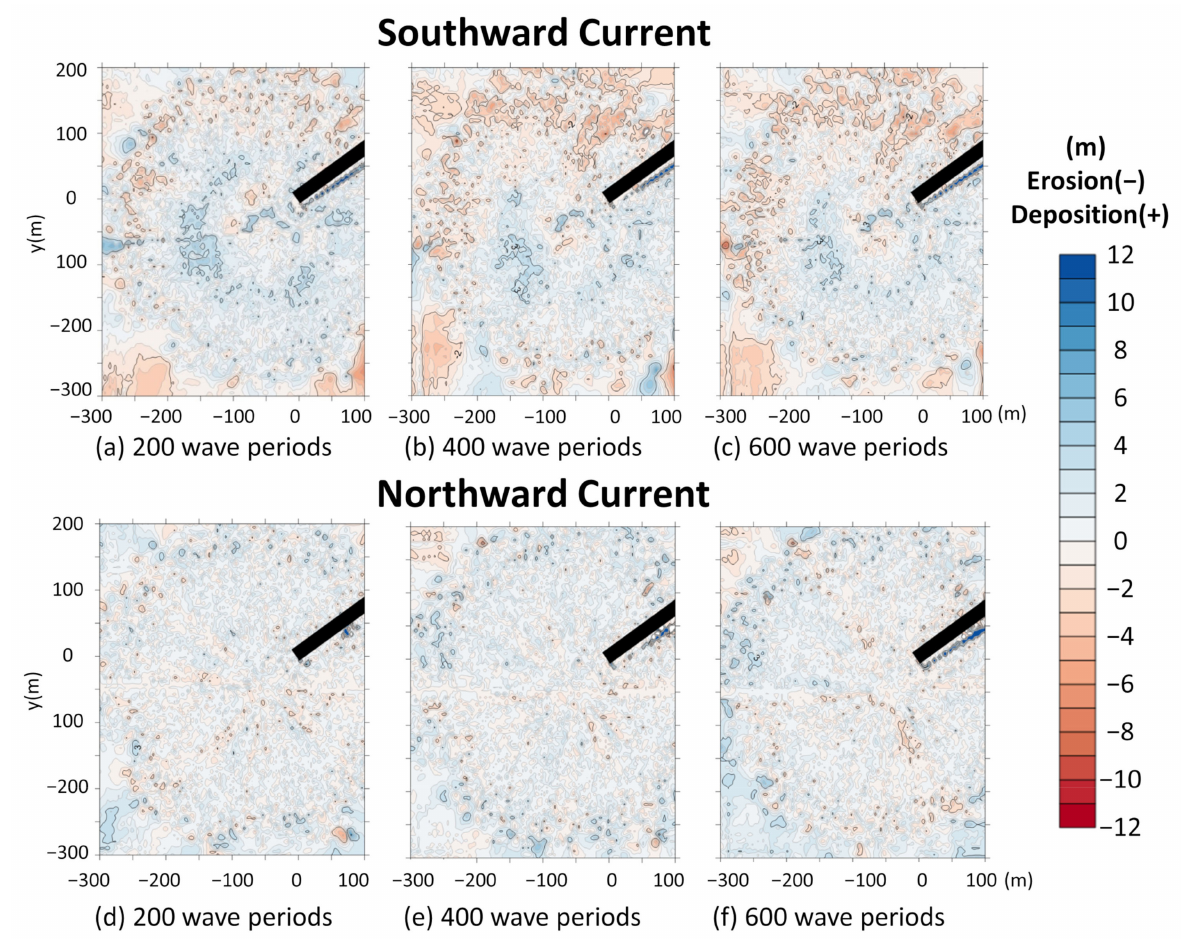
Figure 30. Topographic change under 1, 2, 3 h action of